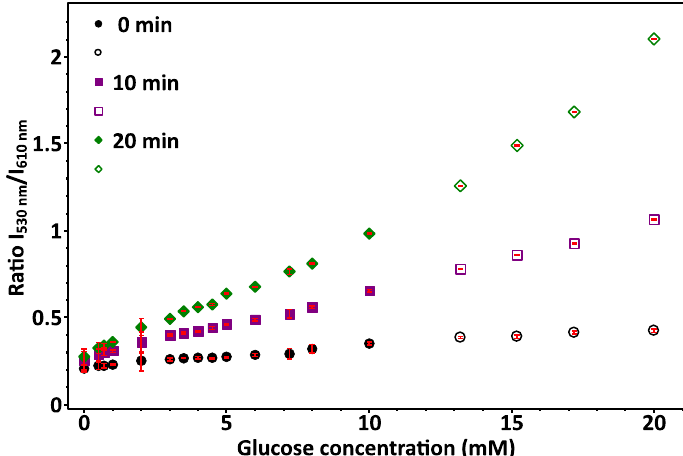
Figure 4. Glucose sensing measuring change in PL emission of the two wavelengths. Measurements were done at λ Ex 555 nm, λ Em 612 nm (unoxidized peak), and λ Ex 445 nm, λ Em 530 nm (oxidised peak). Ratios of the mean (three replicates) 610 nm (un-oxidised) and 530 nm (oxidised) emission intensities corresponded to glucose concentrations. Data was measured at ~10 min intervals. A linear range was seen for glucose concentrations between 0 and 10 mM. Error bars are standard